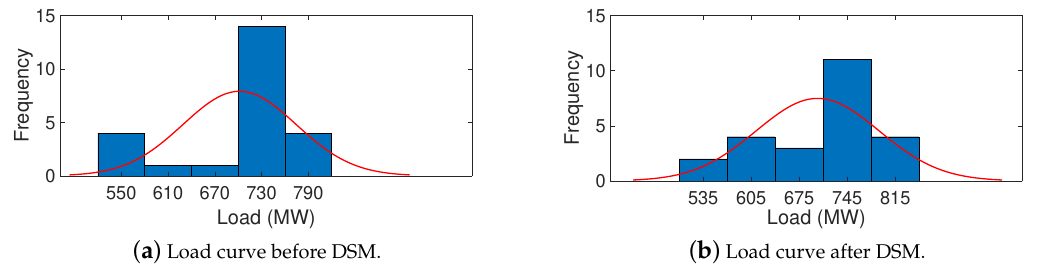
Figure 6. Effect of proposed DSM scheme on load profile.